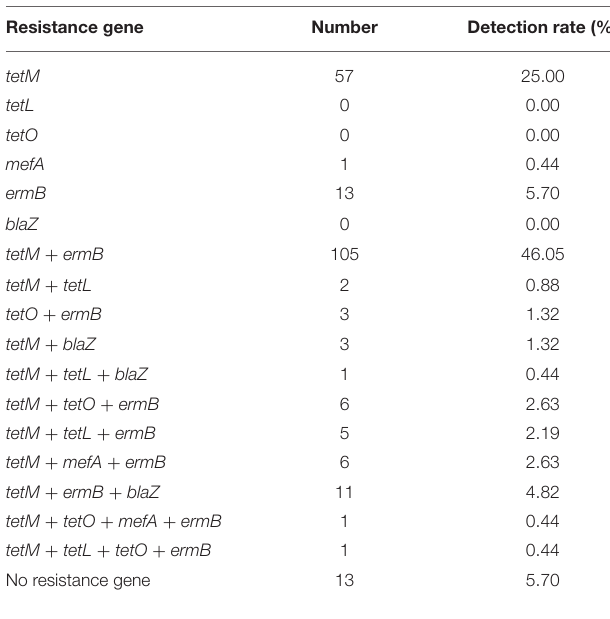
TABLE 8 | Distribution of antimicrobial resistance gene patterns among Streptococcus uberis ( n = 228) isolates from dairy cattle with bovine mastitis in northern Thailand during